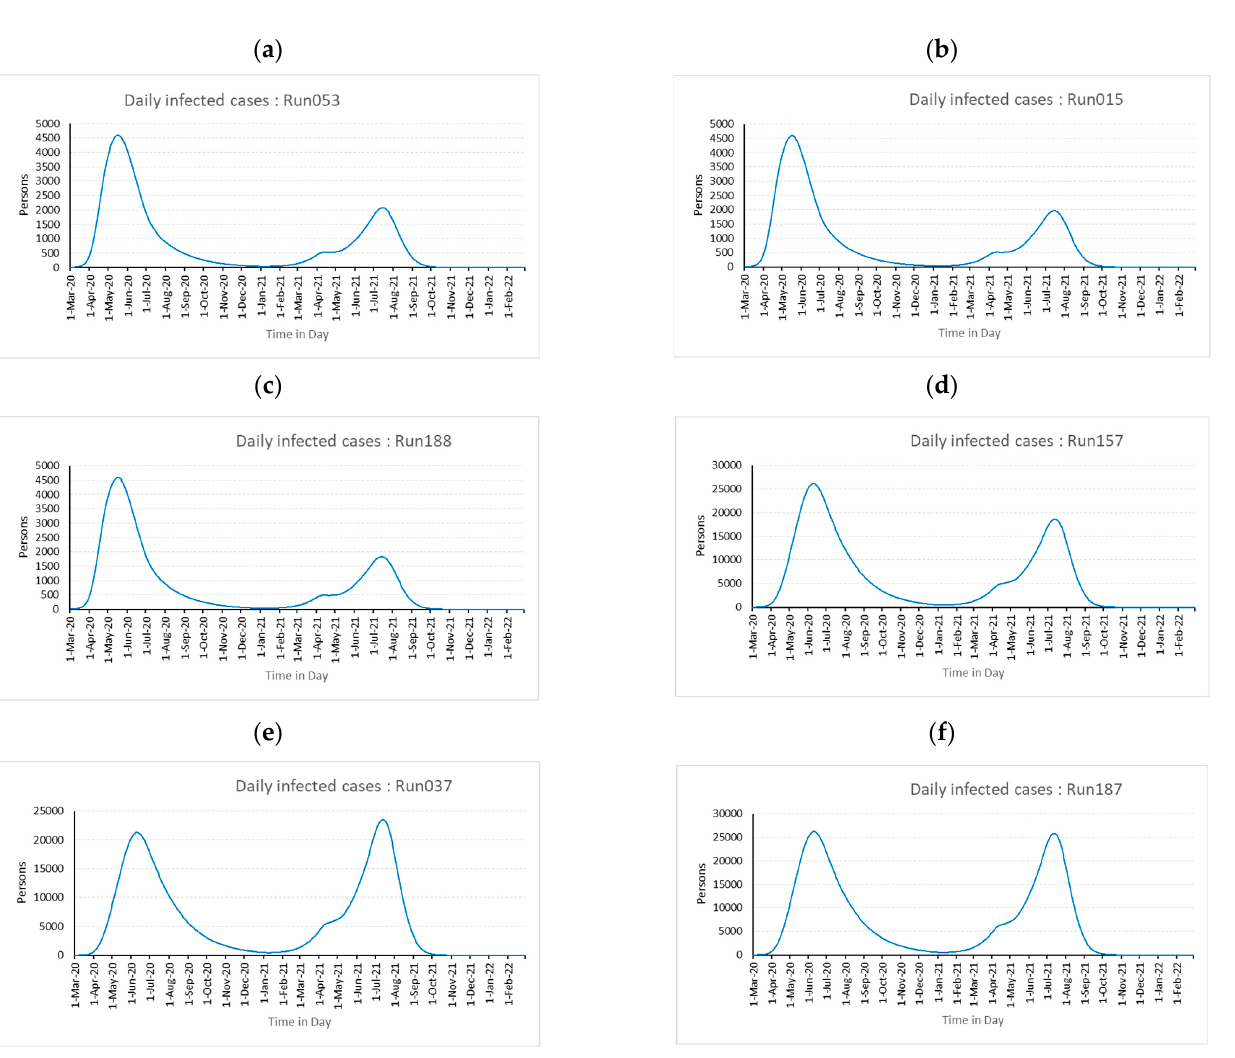
Table 4. Three best and worst runs parameters.